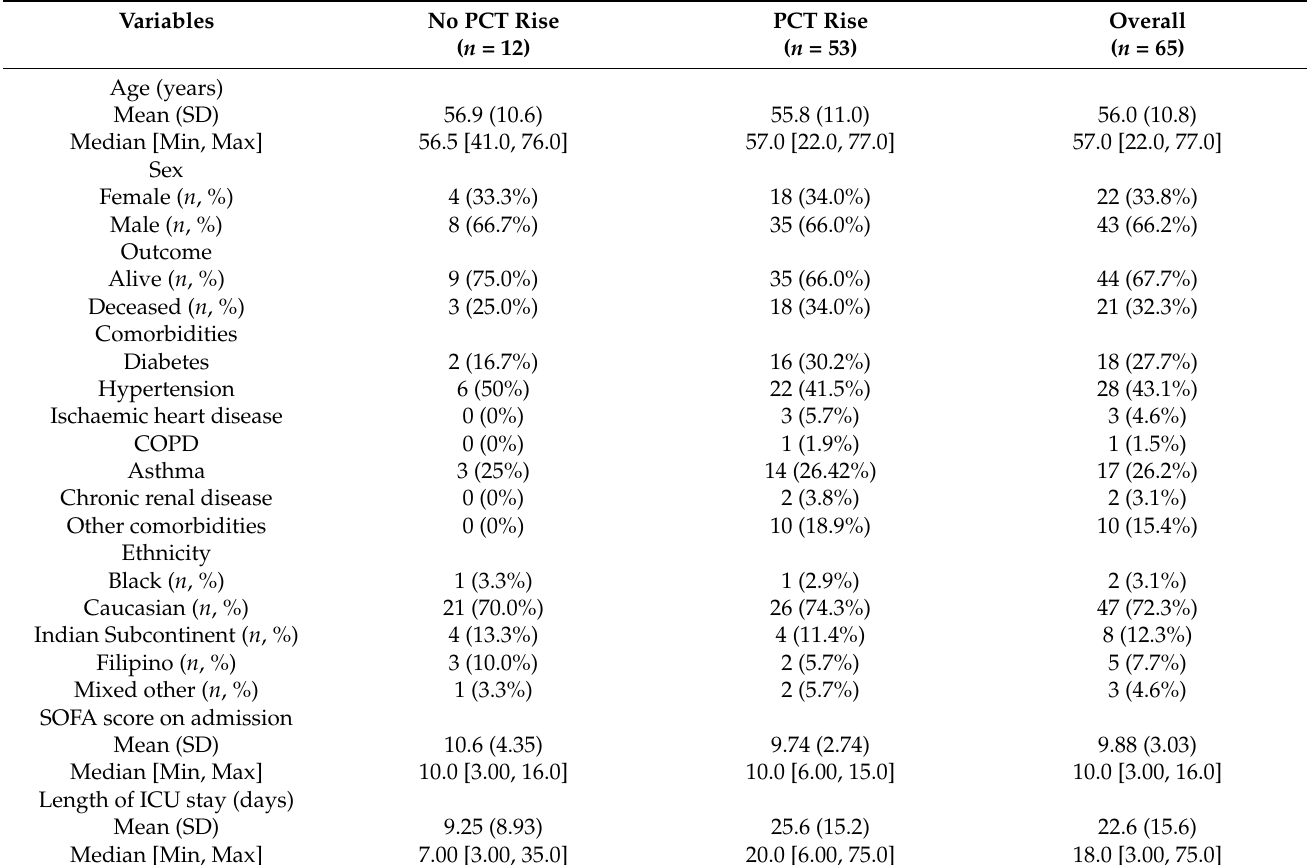
Table 1. Demographics, mortality, SOFA scores and length of stay of ICU COVID-19 patients who experienced a rise in PCT and those who did